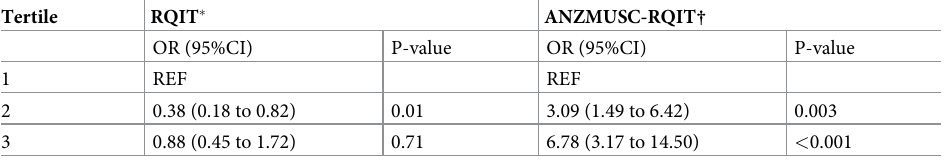
Table 6. Relationship between RQIT scores and journal impact factor group (low or high). The odds ratios are obtained by logistic regression for tertiles of